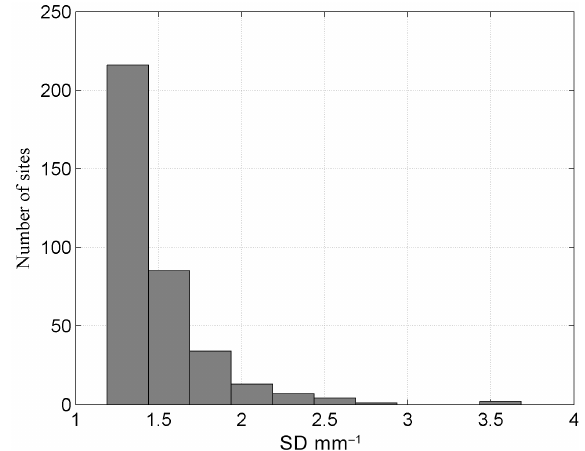
Figure 6. Histogram of uncertainty of ZTD at selected IGS sites.